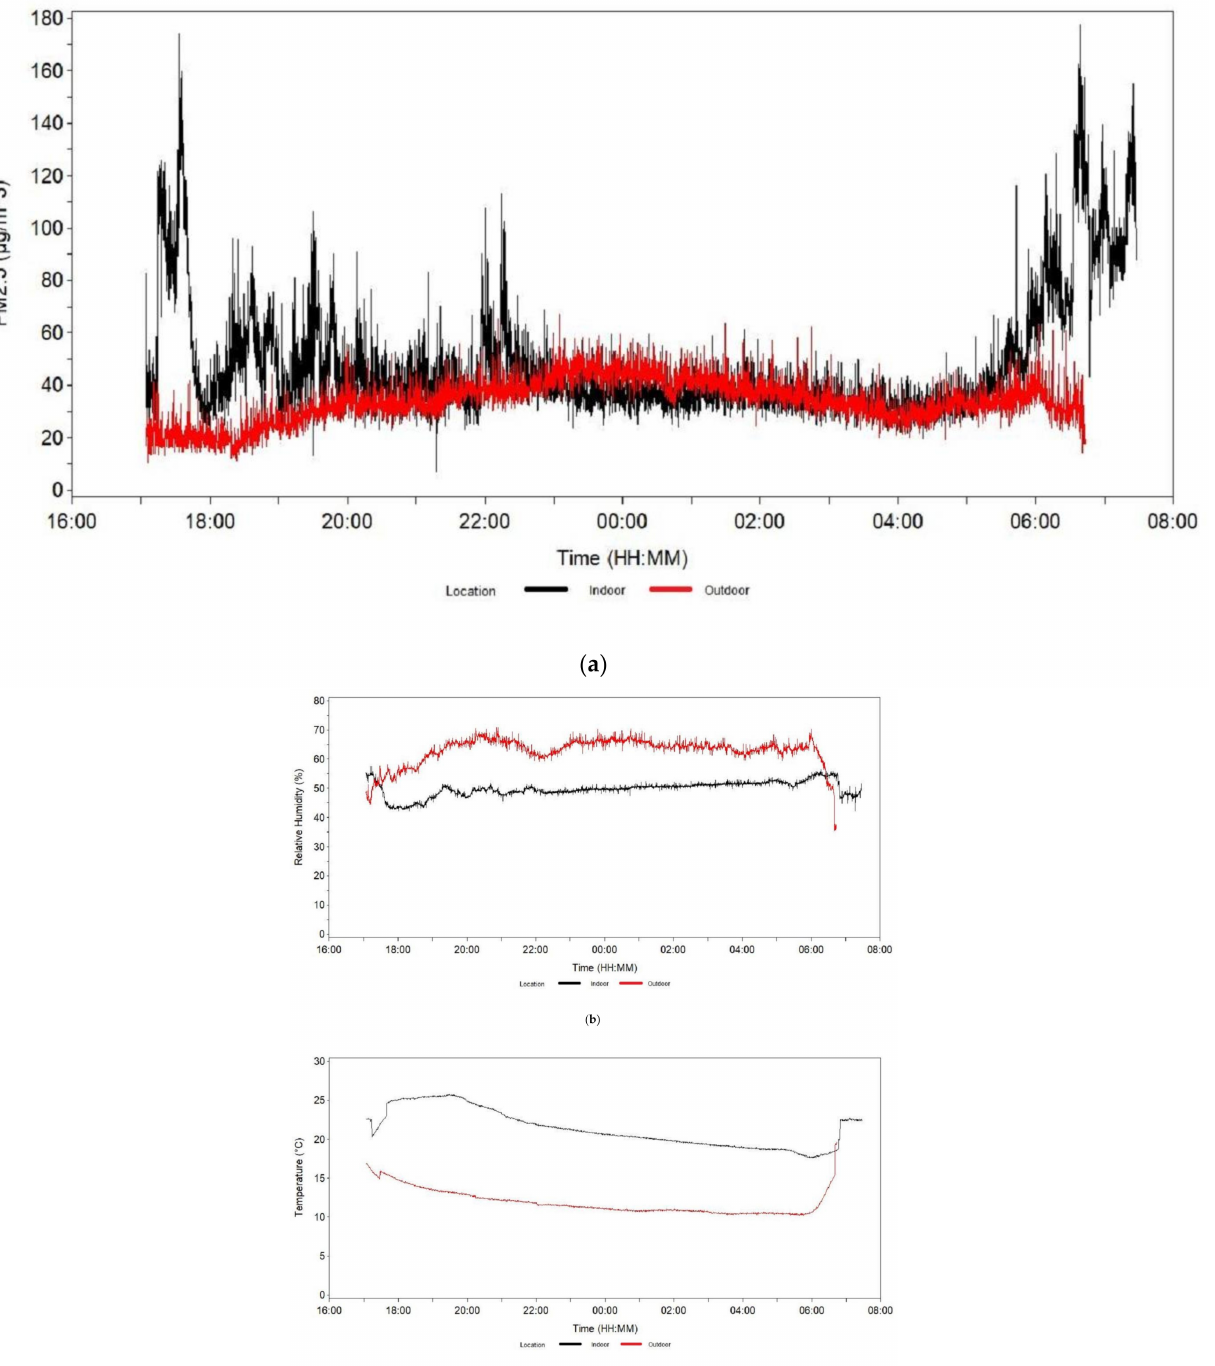
Figure 2. Line graphs of the geometric (PM 2.5 ) or arithmetic (relative humidity, temperature) mean (over location categories) of samples inside or outside teahouses in villages along the Poon Hill circuit trek, Nepal, May 2019: ( a ) PM 2.5 , ( b ) relative humidity, ( c ) temperature. Abbreviation: PM 2.5 , particulate matter with an aerodynamic diameter less than 2.5 µ